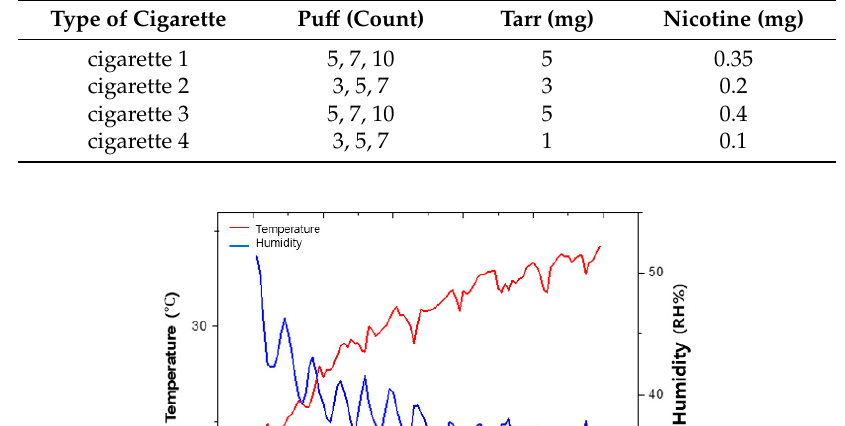
Figure 2. The experimental atmosphere: temperature and humidity changes.